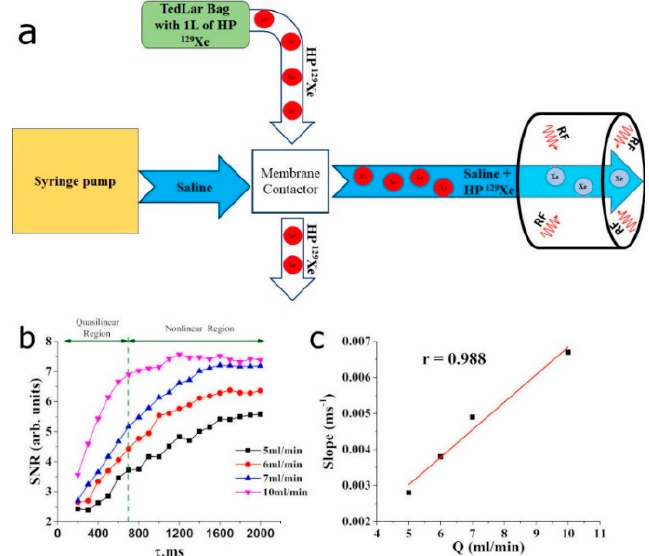
Figure 2. In vitro phantom design and obtained time-of-flight (TOF) 129 Xe curves with Pearson’s correlation coefficient. ( a ) Schematic diagram of the flow phantom used in this study. A syringe pump provided four different flow rates, i.e., 5 mL/min, 6 mL/min, 7 mL/min, and 10 mL/ min. ( b ) 129 Xe TOF recovery curves were measured using the TOF imaging approach. A difference in flow rate of 1 mL/min created well-detected differences in the TOF curves. A quasilinear region was observed between 200 ms and 700 ms. A nonlinear recovery appeared for longer recovery times, followed by a steady state. ( c ) Pearson’s linear correlation between the flow rate and the slopes of the TOF curves was calculated at the quasilinear region. A strong positive correlation (r ≈ 0.988) was observed, indicating the potential to use this slope for flow mapping.